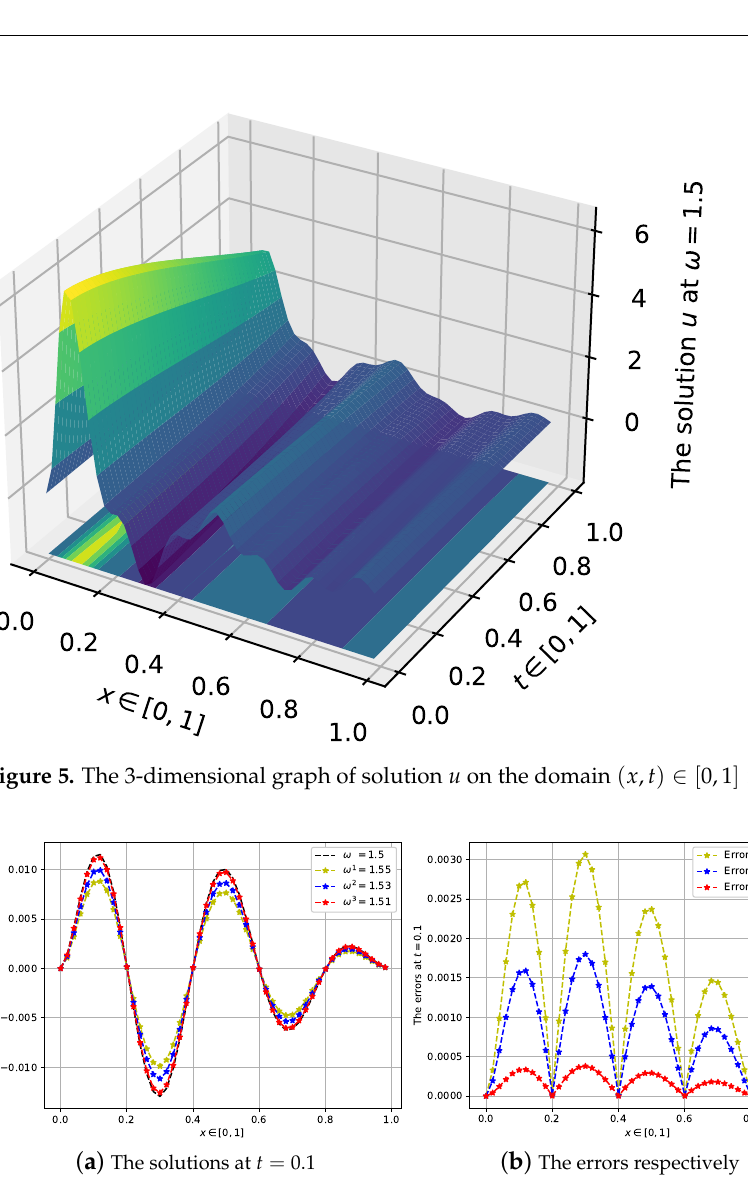
Figure 6. The solution u for ω = 1.5, ω i ∈ { 1.55,1.53,1.51 } at t = 0.1 and the respective error.